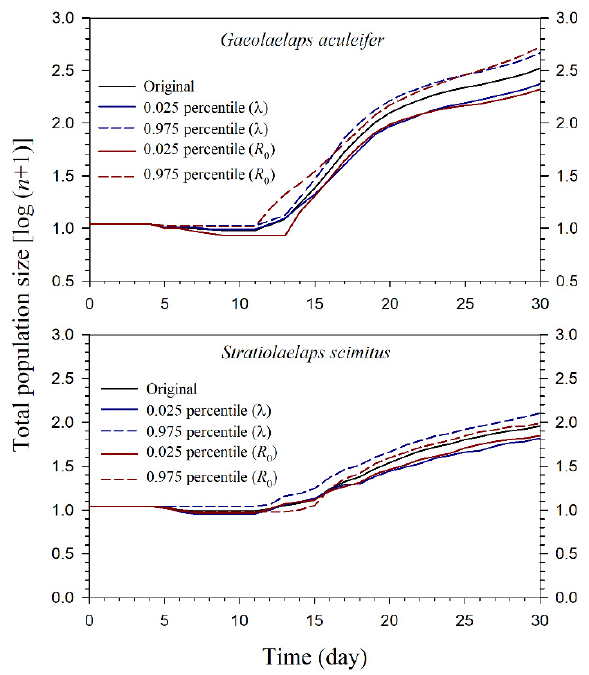
Figure 7. Population projection of G. aculeifer and S. scimitus using life tables of the original cohort; the cohorts were constructed based on the 2.5% and 97.5% percentiles of finite rate of increase ( λ ) and net reproductive rate ( R 0 ).